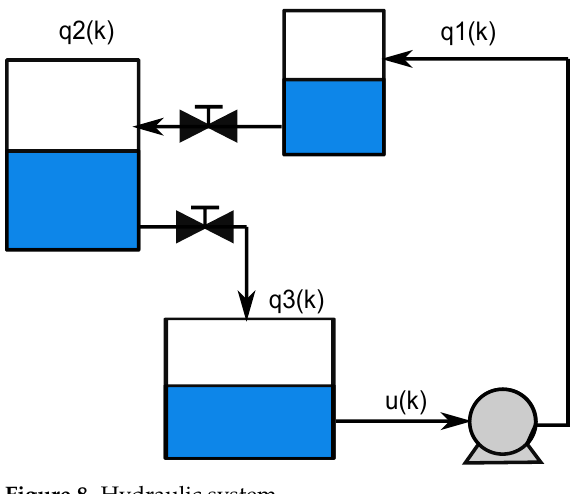
Figure 8. Hydraulic